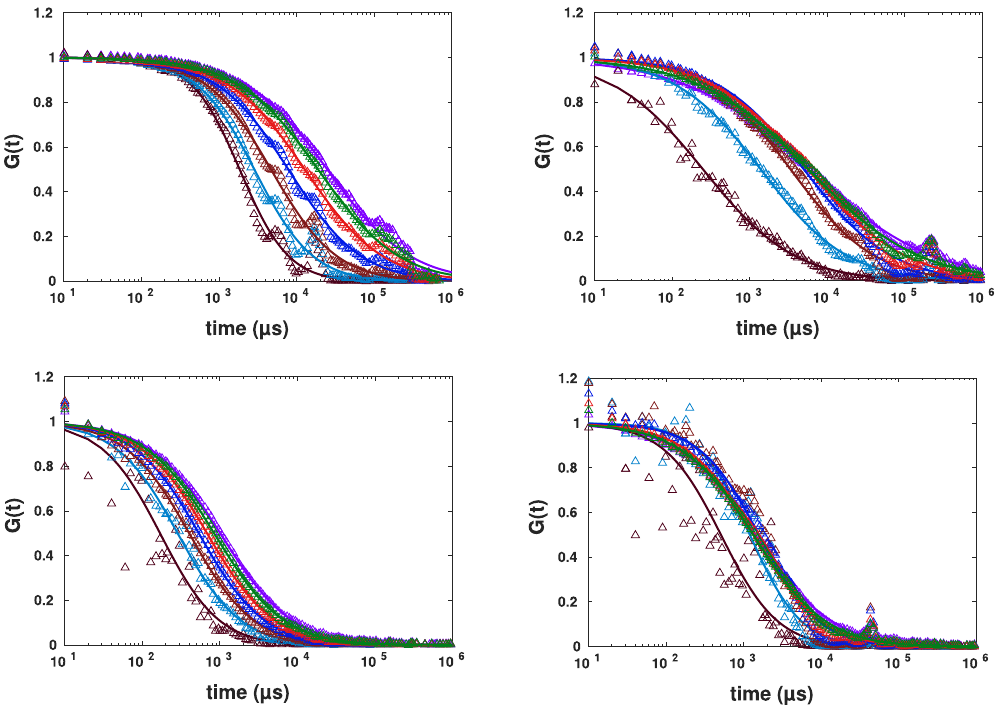
Figure 13. Spot variation FCS with post-processing for four independent measurements in four different samples ( r 0 − 0.4 r 0 from right to left). The curves were fitted to the standard formula with free fit parameter of exponent of diffusion. The intensity time traces were generated using binning method.